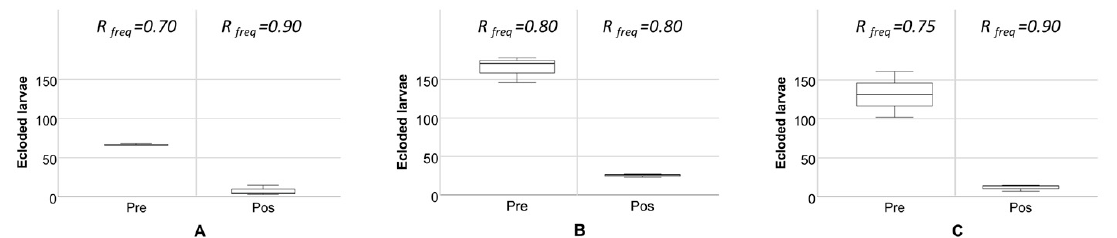
Figure 3. Boxplot of Bactrocera oleae larvae ecloding before and after the application of the dimethoate, highlighting the differences (site locations ( A – C ) on Figure 1b). R allele frequency before and after dimethoate application (details in Table S2).